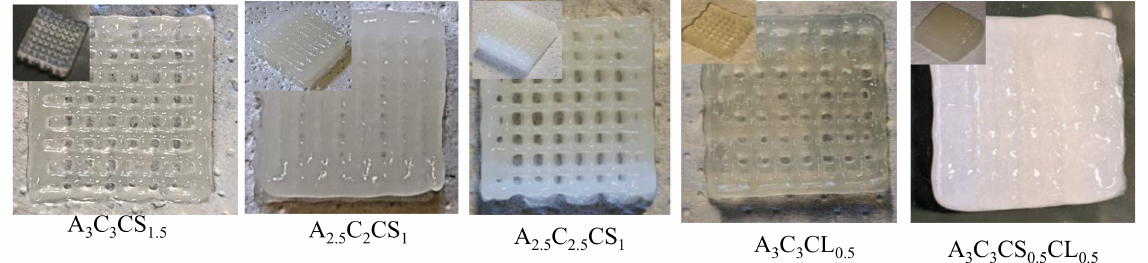
Figure 12. Samples used to conduct compressive tests. We printed three samples with each composition and observed very minimal differences printed with the same composition. Mechanical test data represents the average of three sample